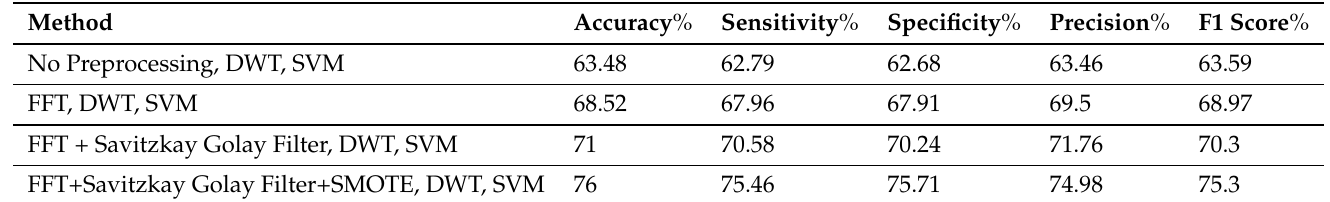
Table 3. Comparison of different preprocessing techniques in terms of accuracy, sensitivity and